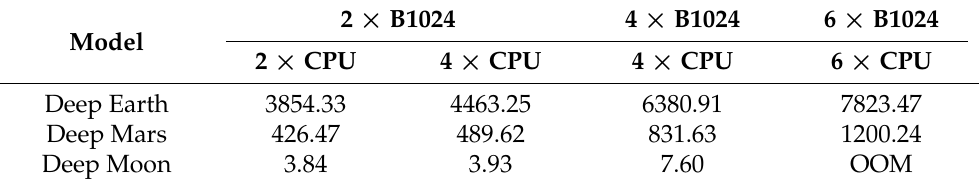
Table 10. Offline benchmark results (throughput in samples per second) for B1024 DPU architecture.